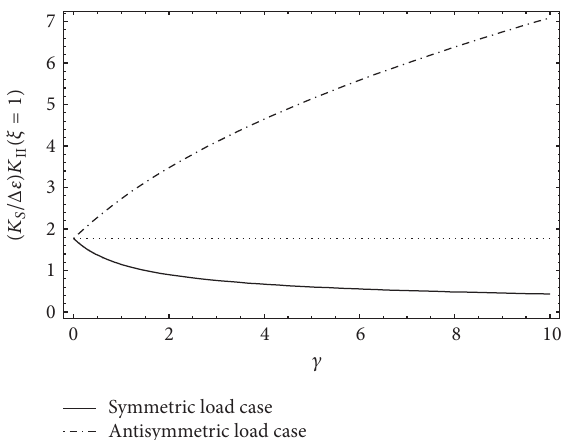
Figure 6: Stress intensity factor at film edge for symmetric loading case.